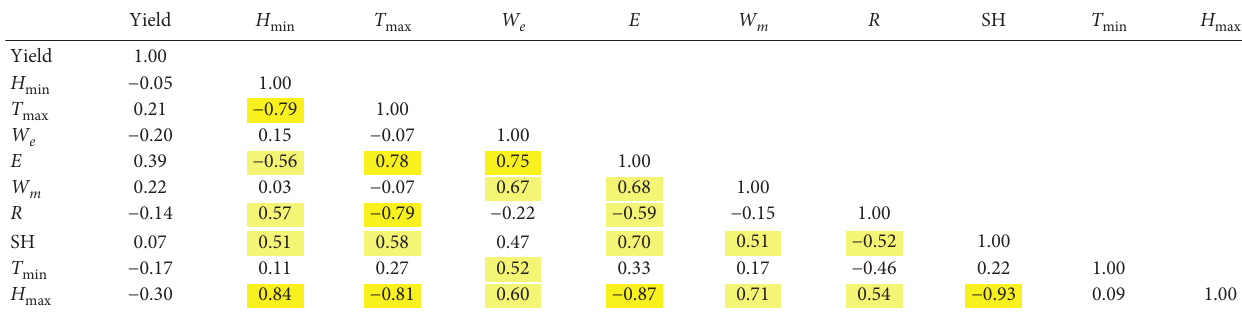
Table 3: Pearson’s correlation